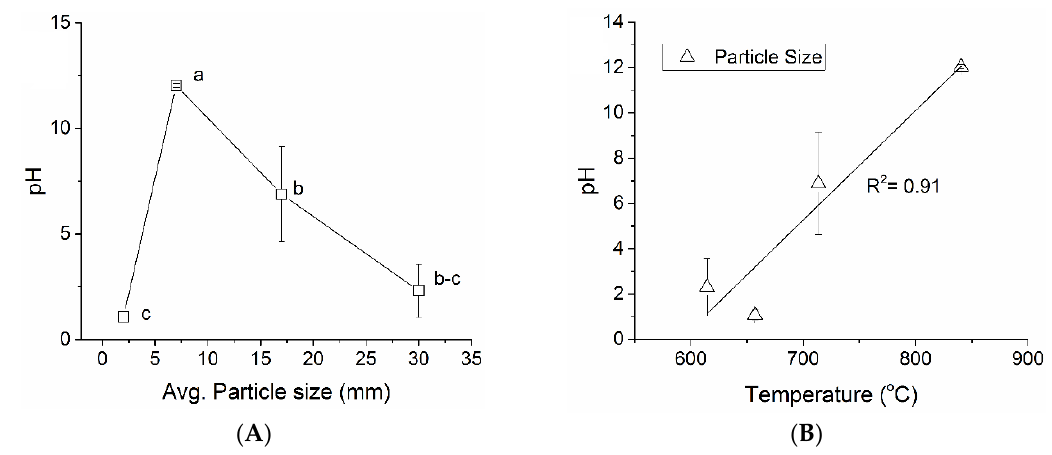
Figure 2. ( A ) pH of biochar produced from wood chips with varying particle sizes (airflow 20 L/min, moisture content 10%, and biomass compactness 0 kg), and ( B ) the correlation between pH and reaction temperature. Di ff erent letters represent significant di ff erence level at